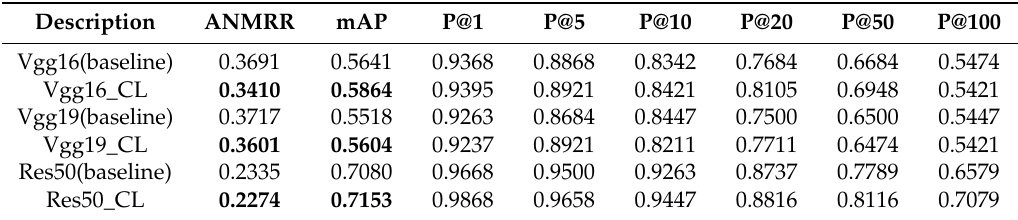
Table 5. Comparisons of different CNNs (Convolutional Neural Networks) under different loss functions. CL means that the network is trained under the supervision of the softmax loss function and the center loss function. The best result for each baseline CNN is reported in bold.